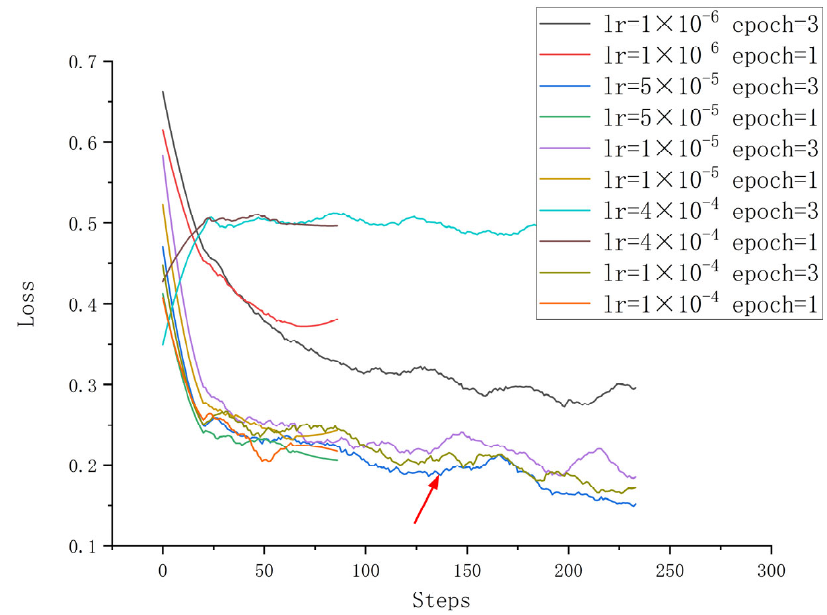
Figure 5. Loss curve graph.